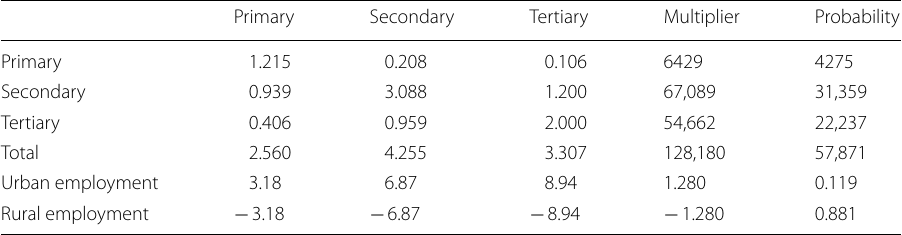
A unit of household consumption is in yuan and employment is measured in